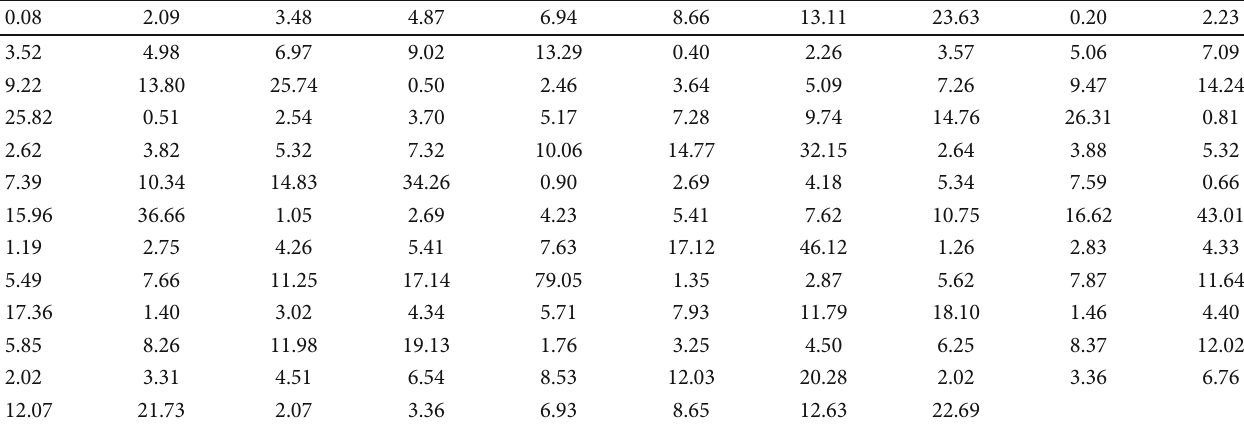
Table 4: Remission times (in month) of bladder cancer for 128